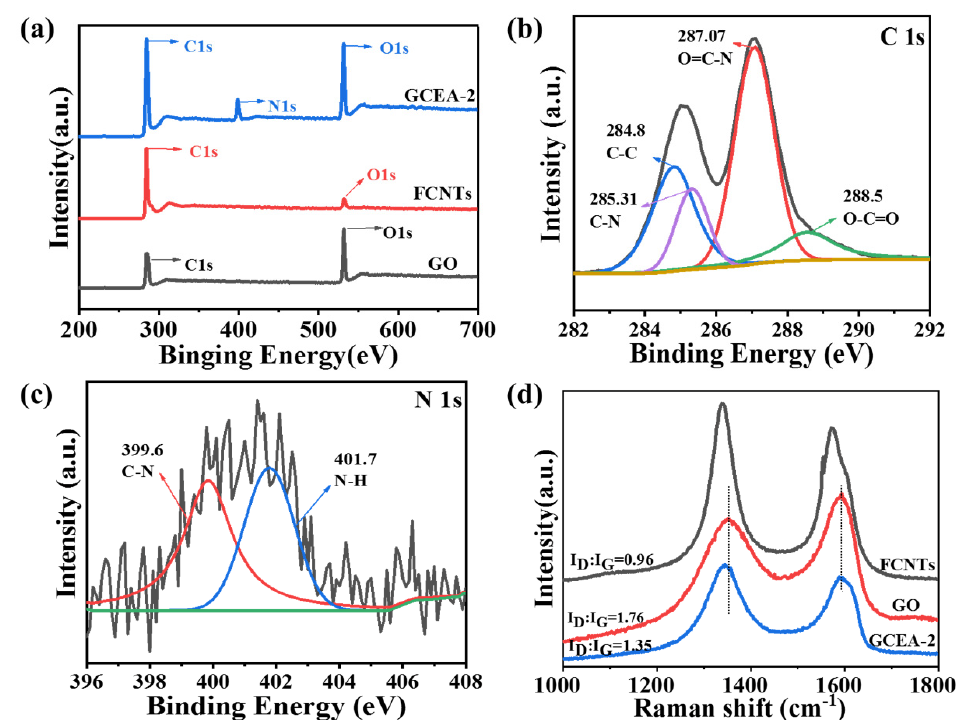
GCEA-2 (Color figure can be viewed Figure 2. ( a ) XPS spectra, ( b ) the C1s and ( c ) N1s of the GCEA ‐ 2, ( d ) Raman spectra of GO, FCNTs, GCEA ‐ 2 (Color figure can be viewed online).